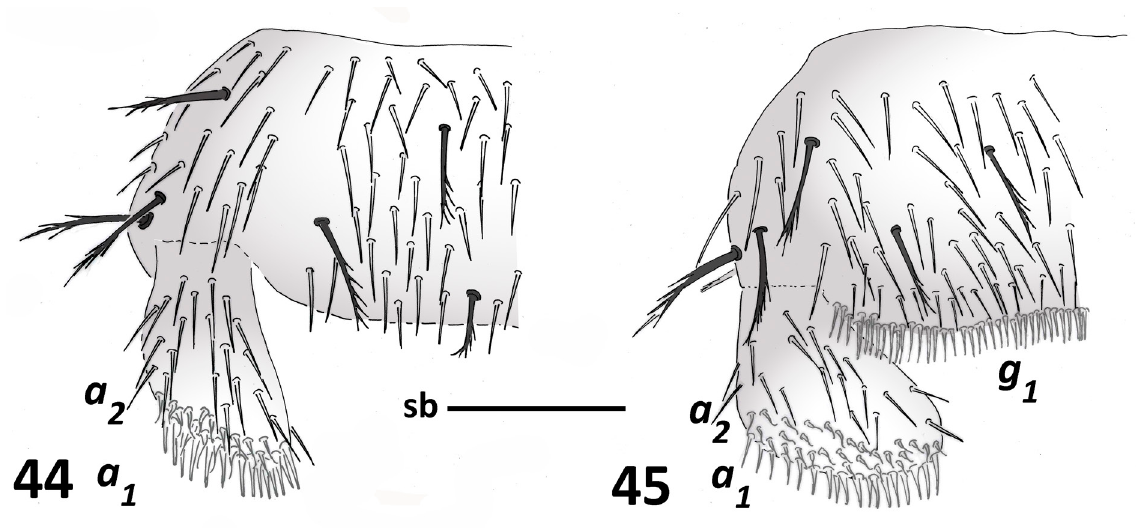
Figs 44–45. Campodea ( Campodea ) meinerti Bagnall, 1918, from Pichoy, France. 44 . ♀, 4.5 mm, first urosternite. 45 . ♂, 3.4 mm, first urosternite. Abbreviations: a